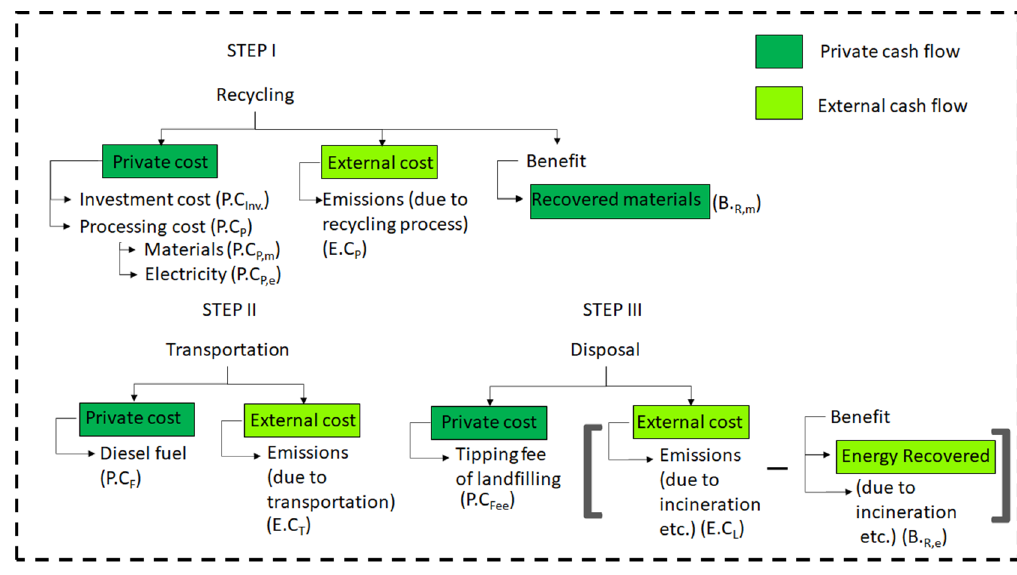
Figure 2. Our framework in analyzing the cost of FRELP recycling method.